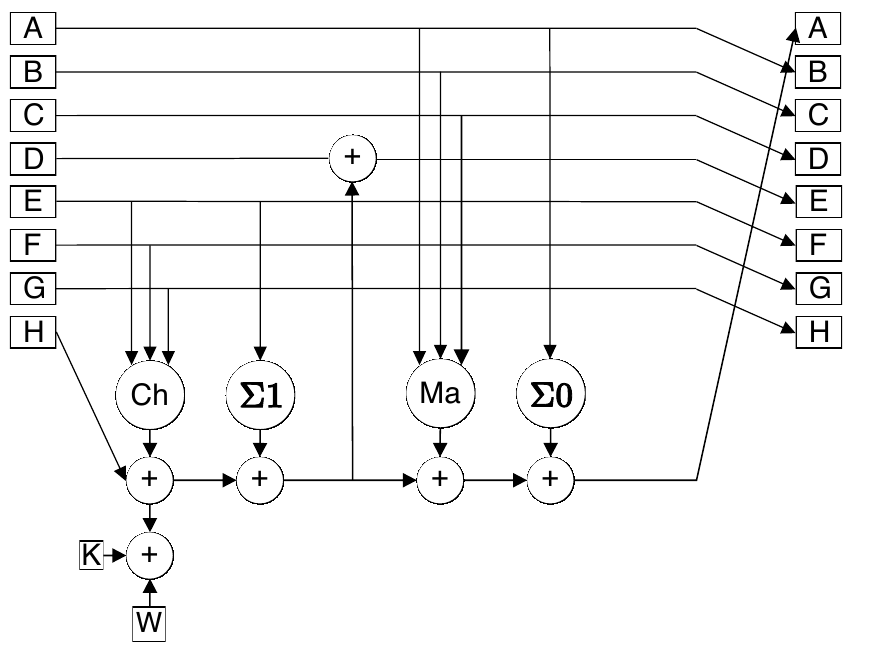
Figure 3. Schematic round of SHA-256 hash function. Table 3. Non-linear functions in SHA-256 and relevant linear equations. Boolean Formula Linear